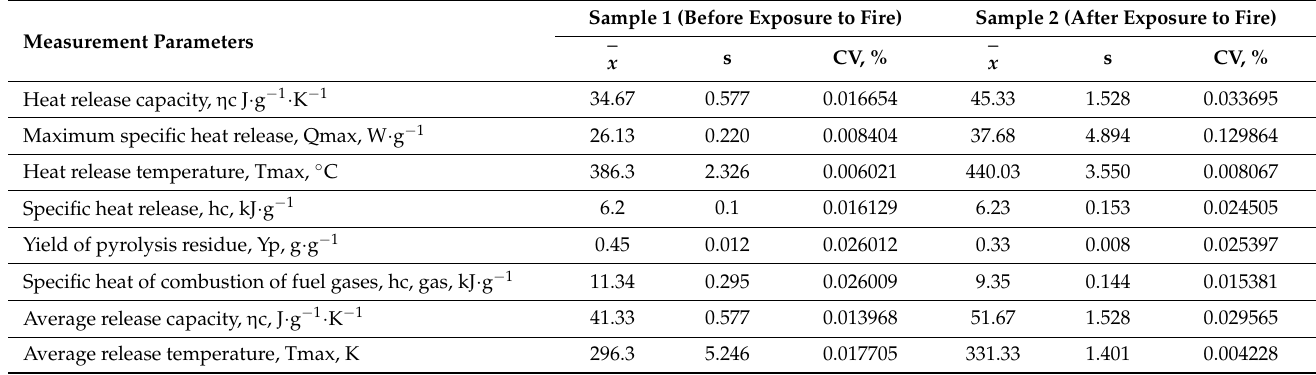
Table 2. Results of the measurement parameters of the samples of parts of the overalls on a mi- crocalorimeter for